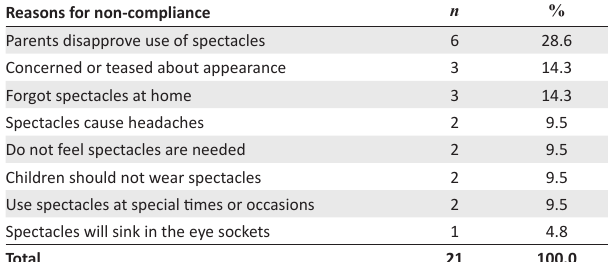
TABLE 4: Self-reported reasons for non-compliance with spectacles wearing among those subjects who reported having being prescribed spectacles previously ( n =